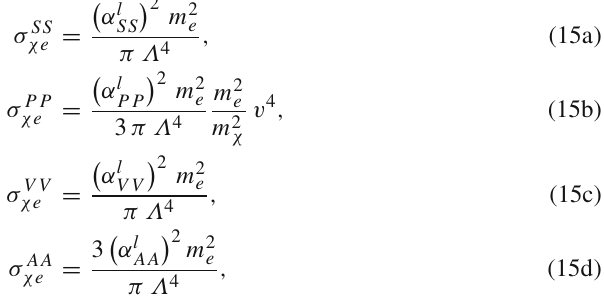
Fig. 2 The scattering cross section of DM on a free electron with the (cid:8) (cid:9) χ e − → χ e − axial-vectorinteractions σ isdepictedfortheDMmass varyingbetween25and400GeV.Thecrosssectionsarecomputedusing the upper limit on Λ obtained from the relic density curves in Fig. 1 corresponding to the flavour-universal couplings for DM with leptons α l = 1. Exclusion plots from DAMA at 90% and 3 σ C.L. for the AA case of DM–electron scattering are also shown [50]. Bounds at 90% C.L. are shown for XENON100 from inelastic DM-atom scattering [51]. The dashed curves show the 90% CL constraint from the Super- Kamiokande limit on neutrinos from the Sun, by assuming annihilation into τ + τ − or ν ¯ ν